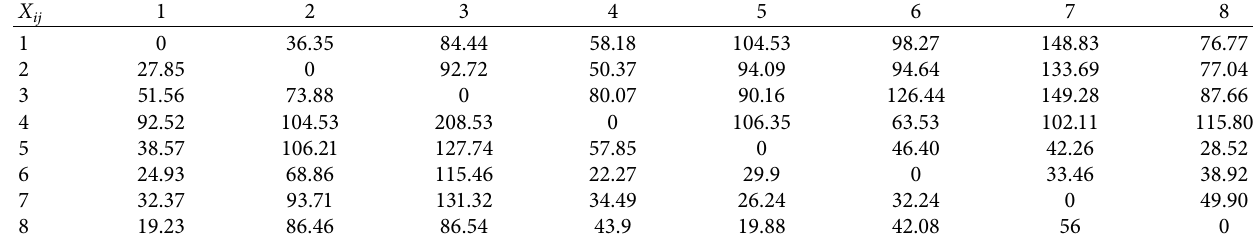
Table 6: Straight-line distance from each breakpoint to each city (unit: km).